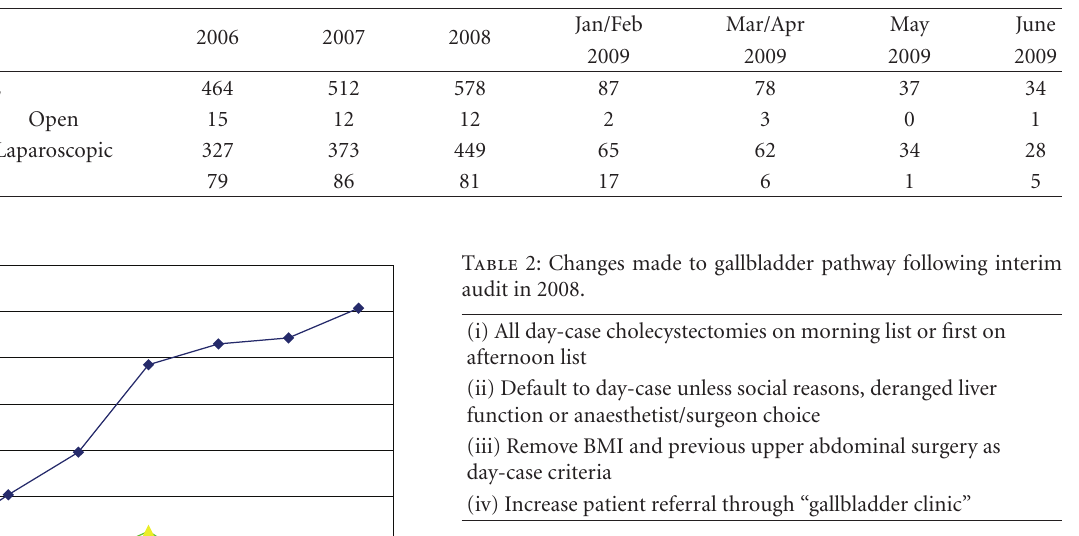
Table 1: Surgical factors relating to cholecystectomies performed between 2006 and 2008.